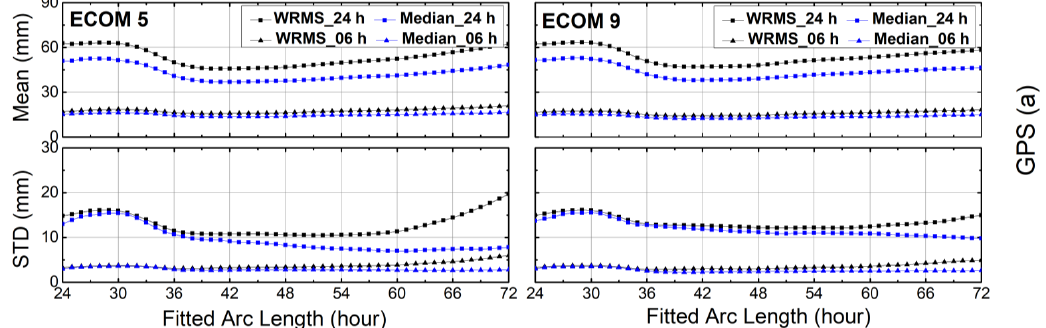
Figure 4. The means and standard deviations (STDs) of weighted root-mean-square (WRMS) and median residuals for orbit differences between predicted orbits and precise ephemerides after Helmert frame transformation over the first 6 h and full 24 h intervals for GPS. Results for reduced Empirical Center for Orbit Determination in Europe Orbit Model (ECOM-5) are shown on the left and for nine-parameter (ECOM-9) on the right planes.